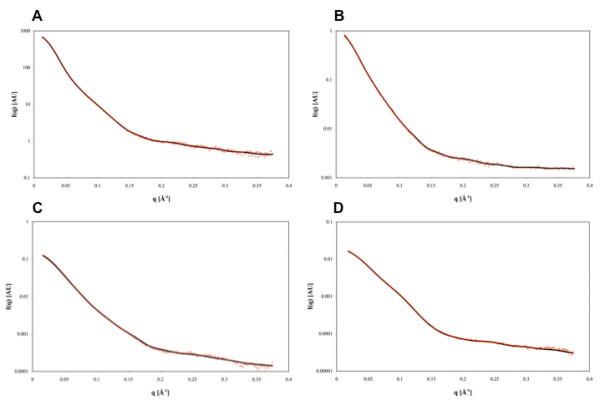
Scattering curves of the different constructs of TraB and of LvhB4. The calculated I(q) profiles (black line) of the four different structures restored from the SAXS data are compared with the measured SAXS data (red circles) for TraBFL (A); TraBNT (B); TraBCT (C) and LvhB4 (D). "AU" stands for "Arbitrary Units".